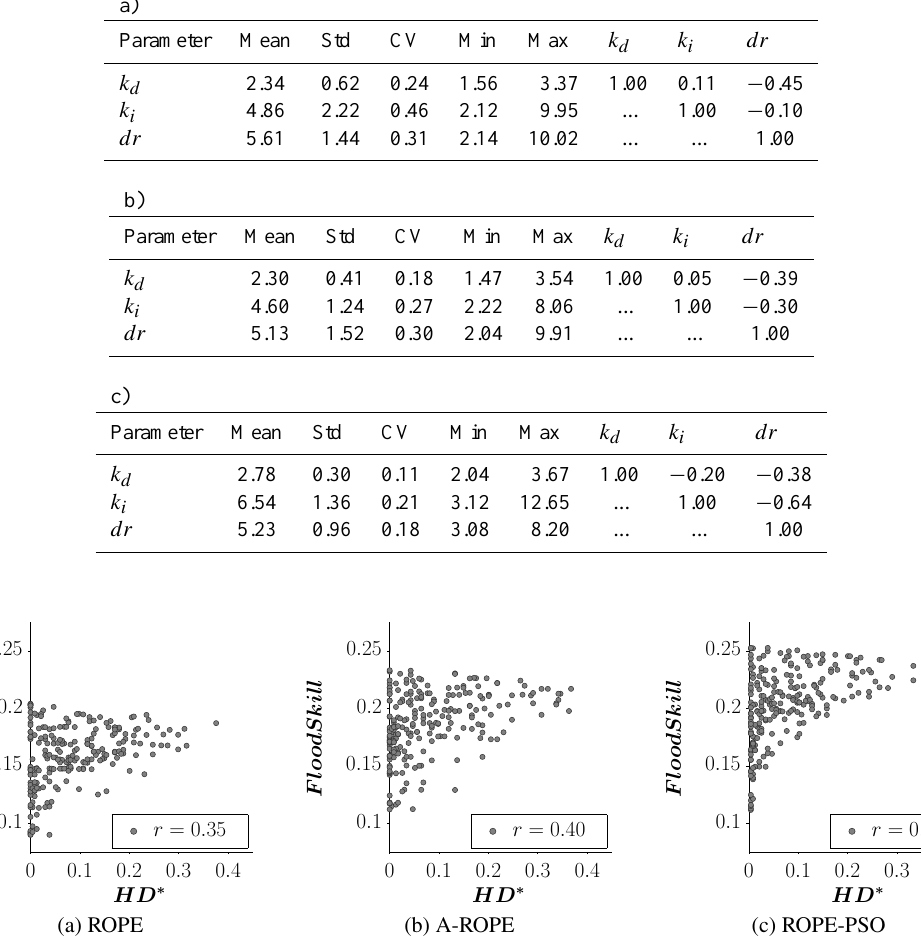
Table 6: Mean value (Mean), standard deviation (Std), coefficient of variation (CV), minimum, maximum and correlation coefficients between the generated samples for the conceptual model parameters estimated by ROPE (a) , A-ROPE (b) and ROPE-PSO (c) .